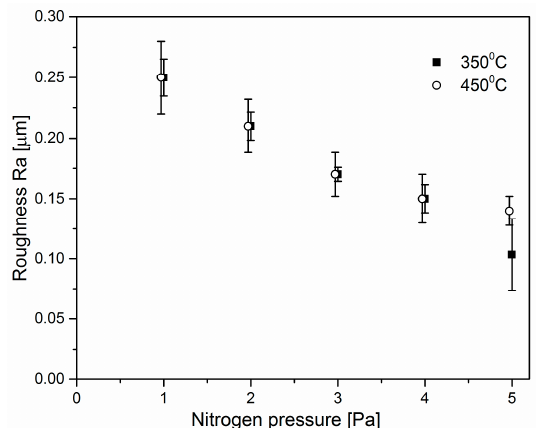
Figure 7. Roughness parameter ( R a ) of AlCrN coatings.